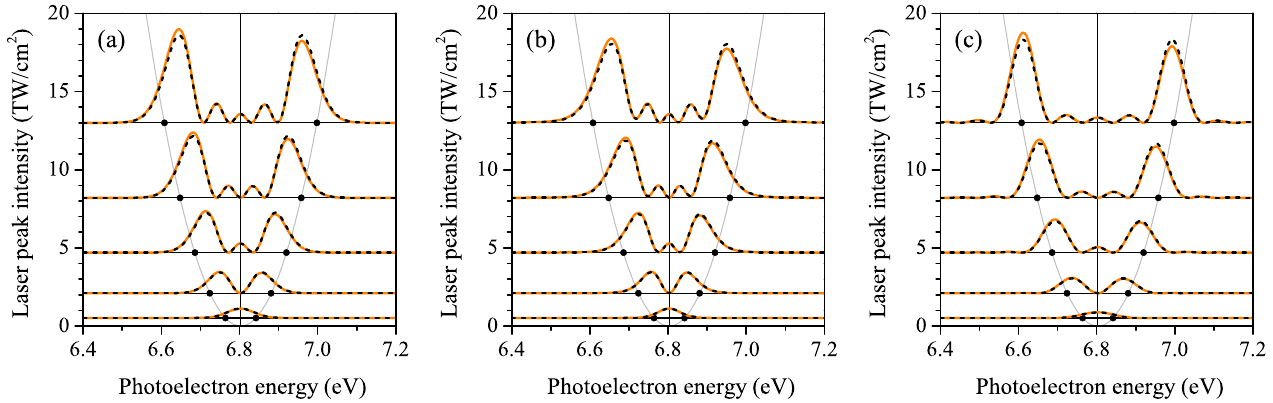
Figure 3. (Color online) Photoelectron energy spectra calculated using the three-level model (Equations (4)–(6)) with exact values of | d ε | 2 (solid orange lines) and with the approximation | d ε | 2 ≈ | d ε | 2 (dashed lines) for: ( a ) Gaussian pulse (7), ( b ) half-Gaussian pulse (8) and ( c ) rectan- 0 gular pulse (9), all of carrier frequency ω = 0.375 a.u. and the peak intensities marked in Figure 2 by vertical dashed lines. Black dots mark the real parts of E ± ( 0 ) + ε 0 , whose separation ( ≈ Ω 0 ) estimates the splitting of the resonant